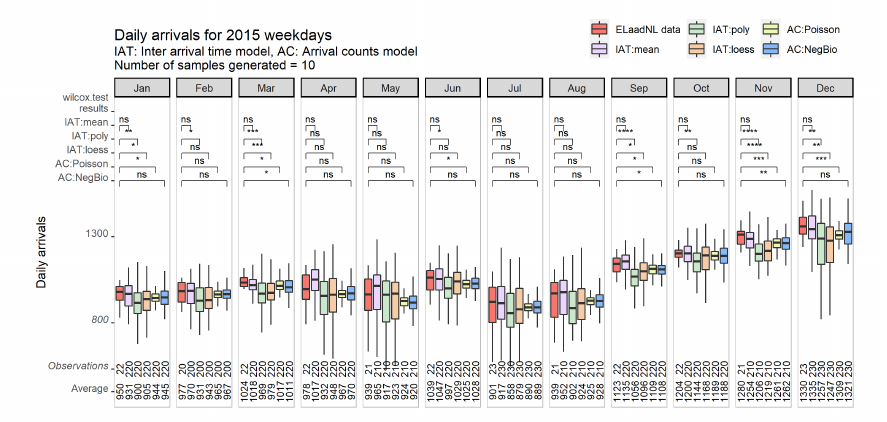
Figure 6. Daily aggregated EV arrivals (2015, weekdays). Significance was calculated based on Wilcoxon tests ( ns : not significant, p -value > 0.05; * p -value ≤ 0.05; ** p -value ≤ 0.01; *** p -value ≤ 0.001; **** p -value ≤ 0.0001).